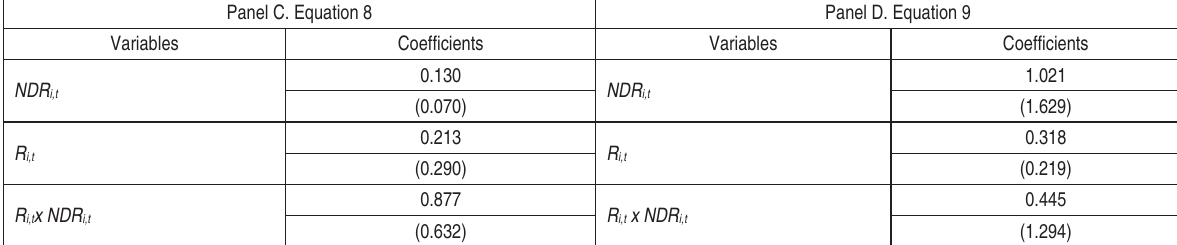
Table 5b. Earnings sensitivity and